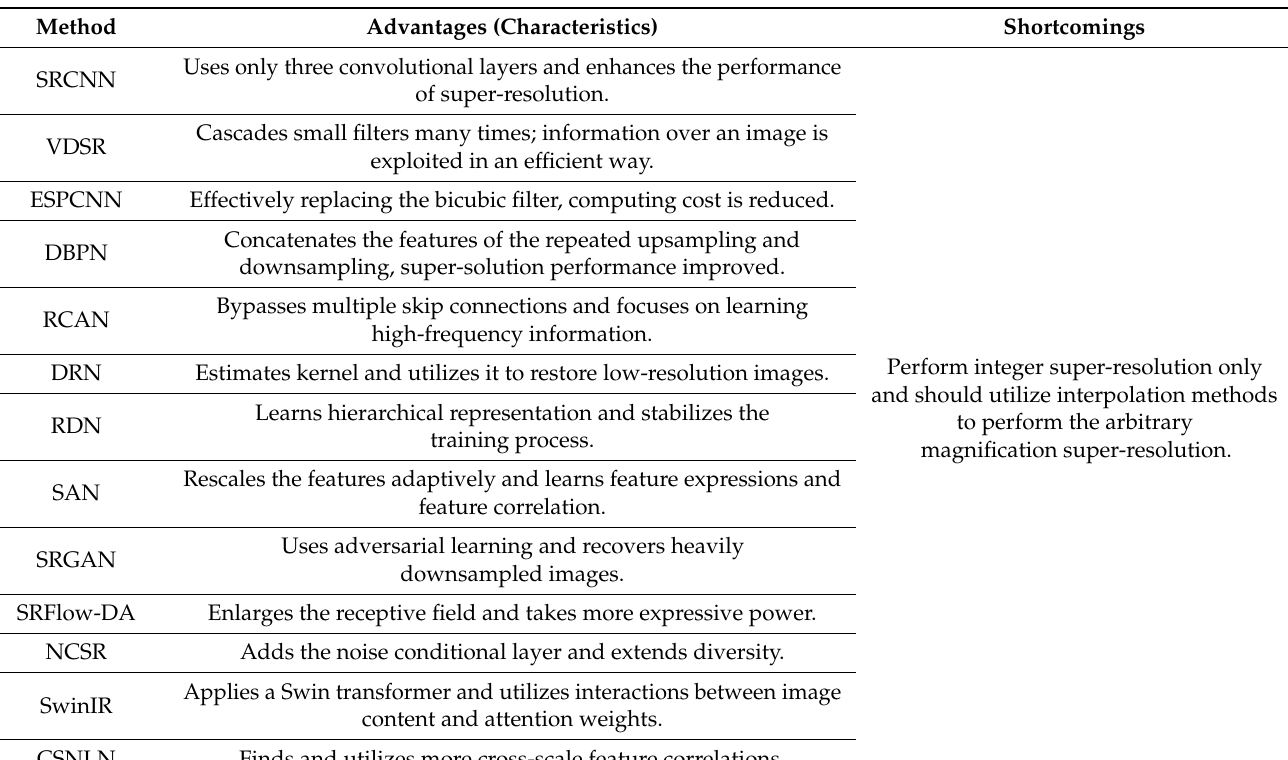
Table 1. Conventional single image super-resolution methods’ advantages and shortcomings. Method Advantages (Characteristics)